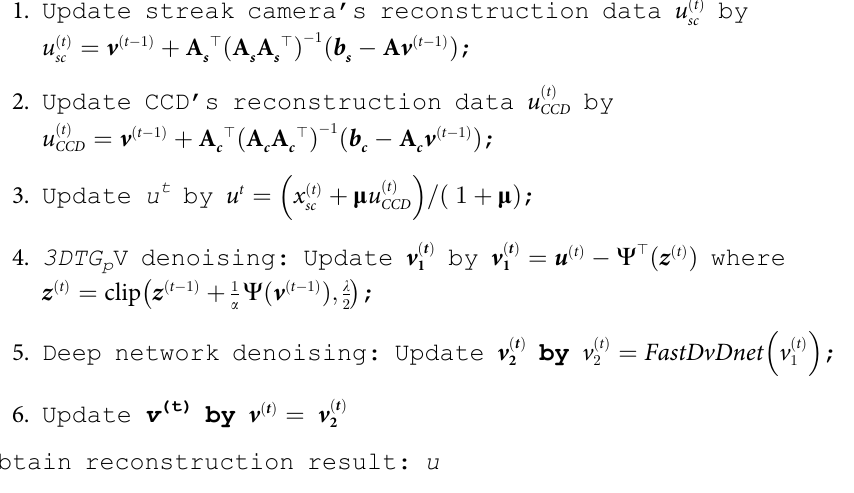
Algorithm 1. PnP- 3 DTG